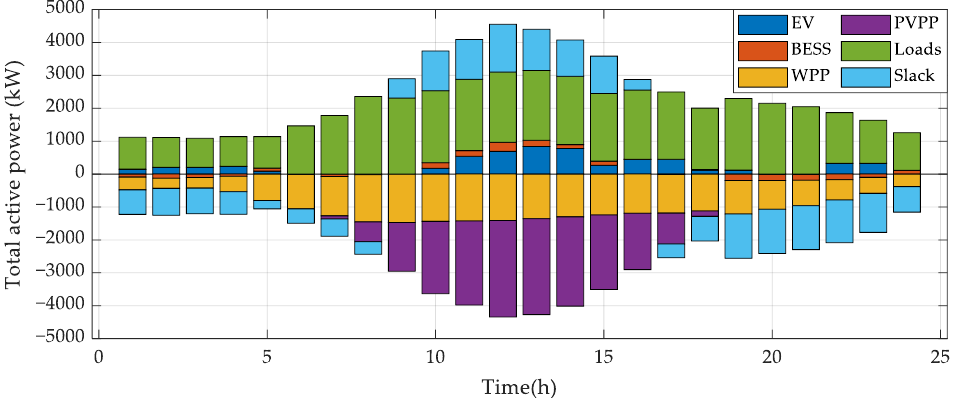
Figure 7. Microgrid active power scheduling resulted after the first OARPC stage for the selected day.